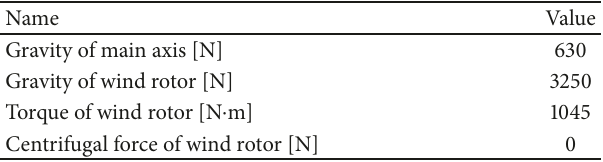
Figure 10: Displacement variation contour of beam. Table 7: Received force of main axis.